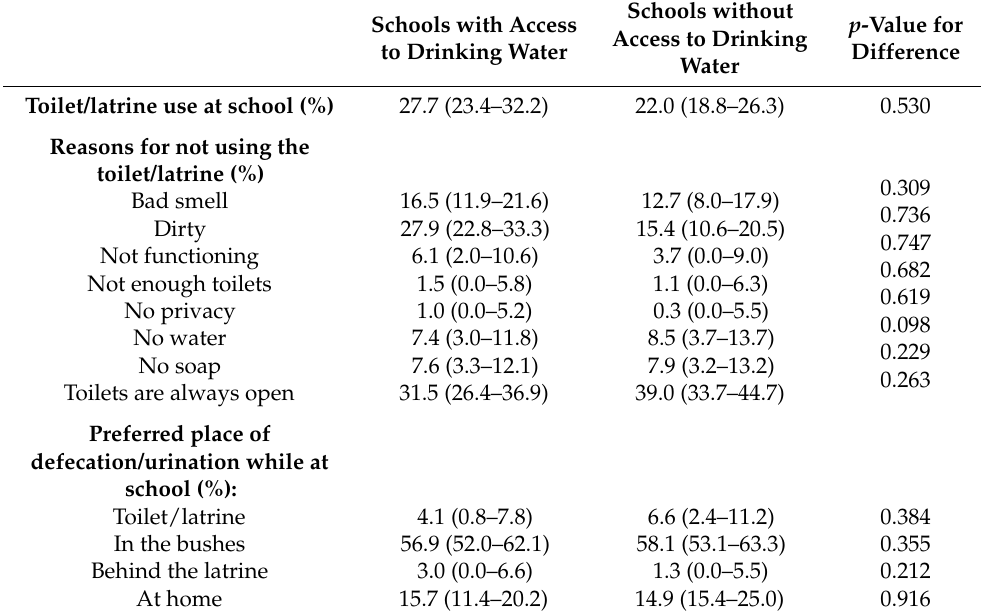
Table 2. Toilet/latrine related knowledge and practices 1 .